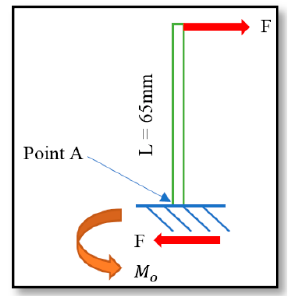
Figure 2. Free ‐ Body diagram of flat spring.